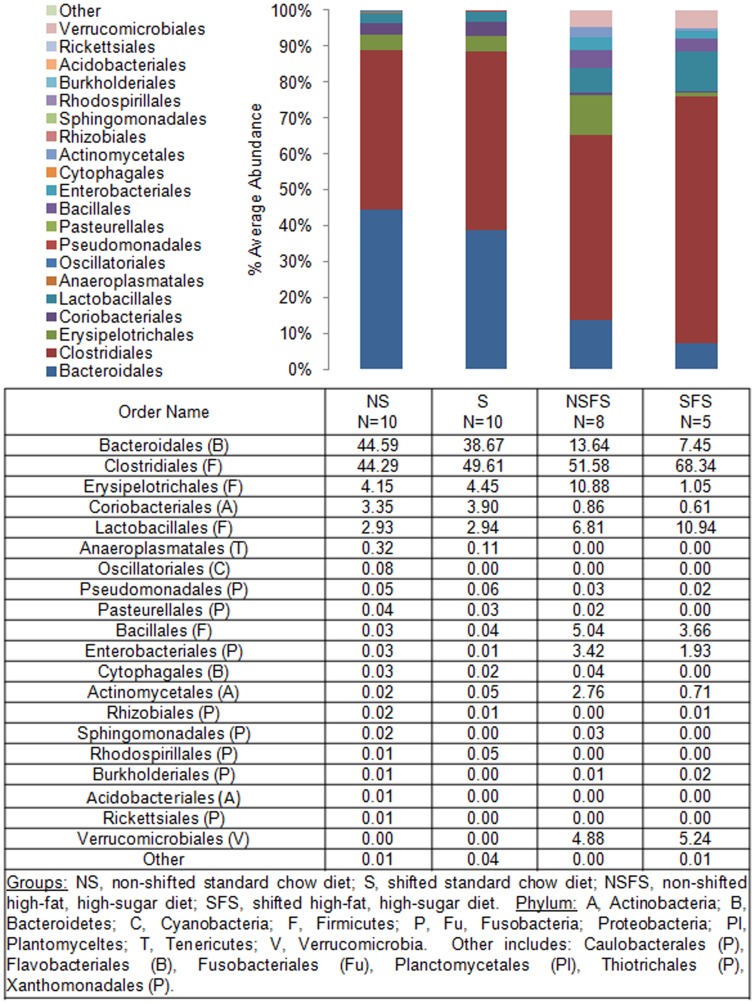
Mouse gut microbial community structure at the order level.The bar graph graphically represents the average relative abundance of classified bacteria SSU rRNA gene amplicons belonging to the most abundant taxon at the order level.